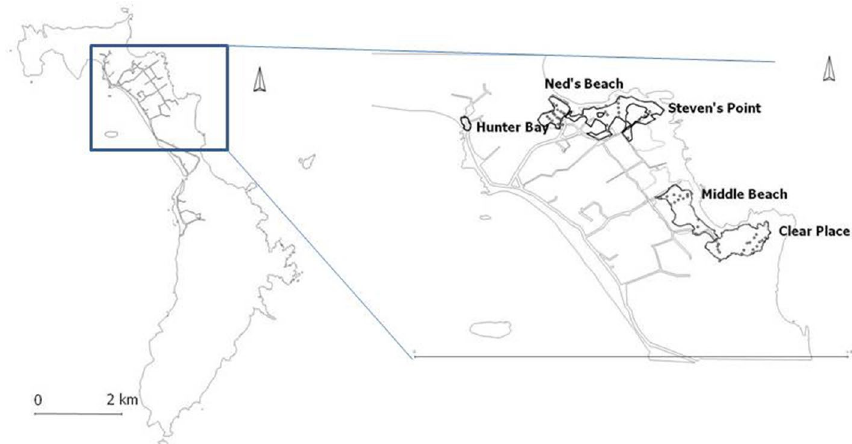
Figure 9. Location of colonies in Lord Howe Island. Map created using R open source software 44–46 using data supplied by authors and Lord Howe Island